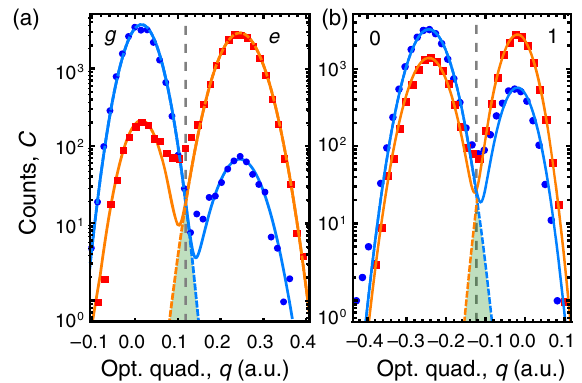
FIG. 10. Single-shot measurements. (a) Histogram of integrated quadrature amplitude q for preparing the state j g i (blue) or j e i (red), as well as (b) for preparing the photon state j 0 i (blue) or j 1 i (red). In each panel, the solid lines are fits to a bimodal Gaussian model whose individual components are indicated by dashed lines. The green areas depict the overlap error. The dashed gray line indicates the selected qubit-state